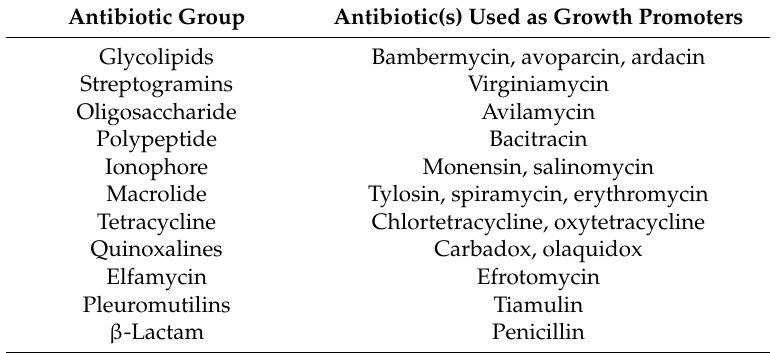
Table 1. Antibiotics used for growth promotion and feed efficiency in food animals